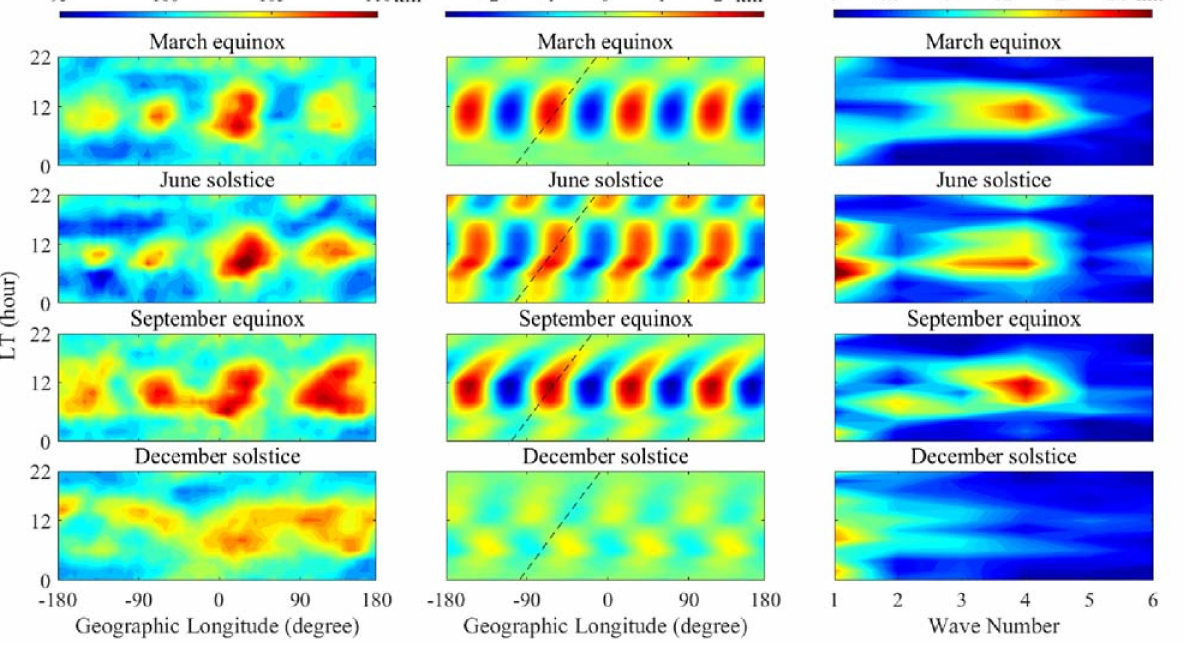
Figure 6. Same as Figure 5, but for 0–30 ◦